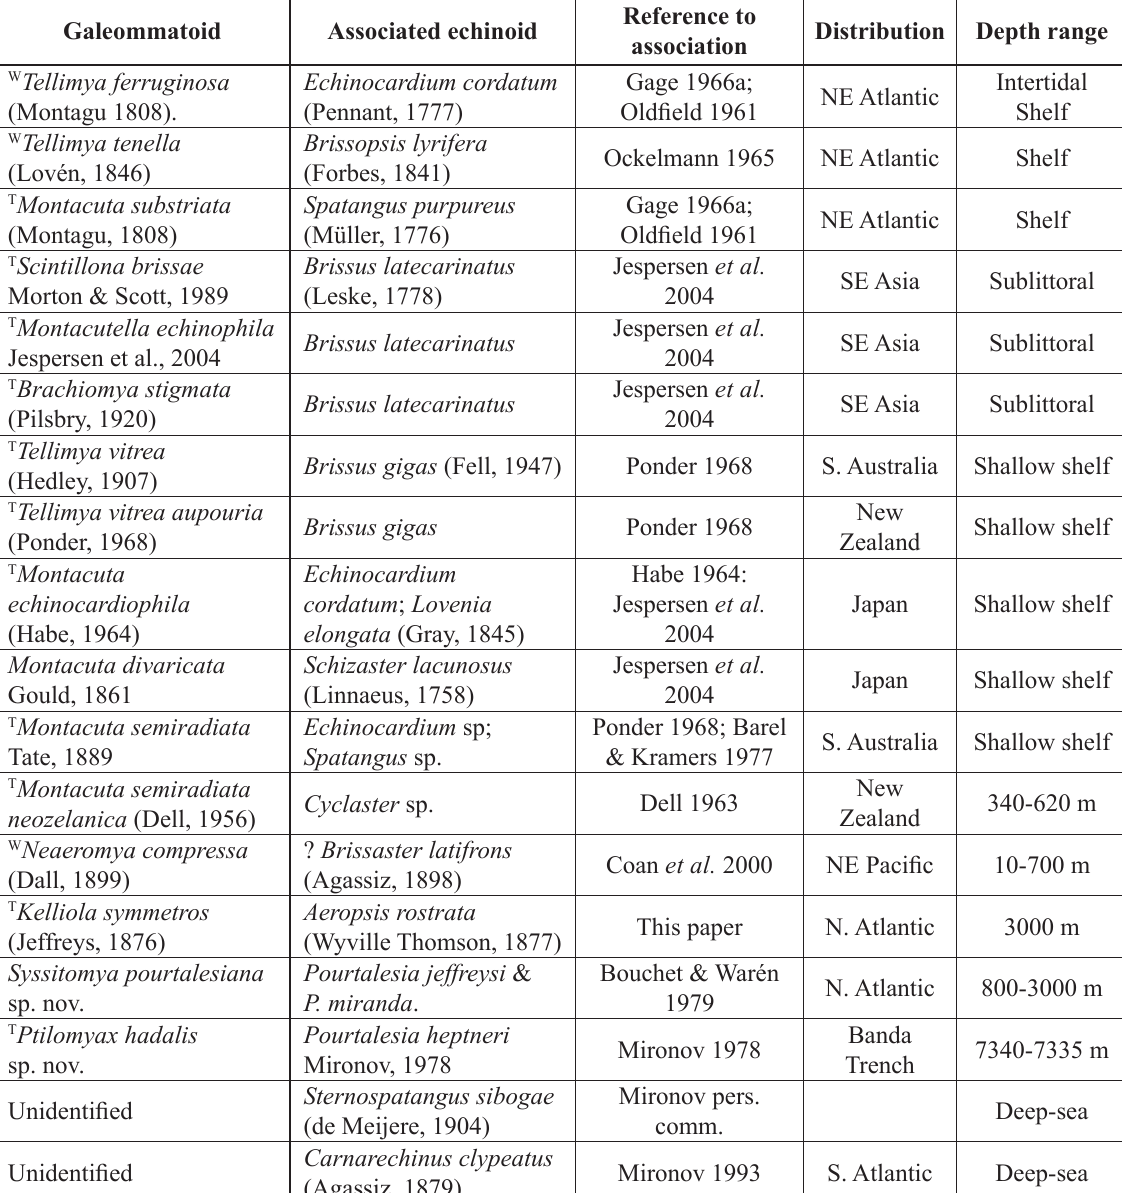
Table 1. Galeommatoid species attached to T or associated with W